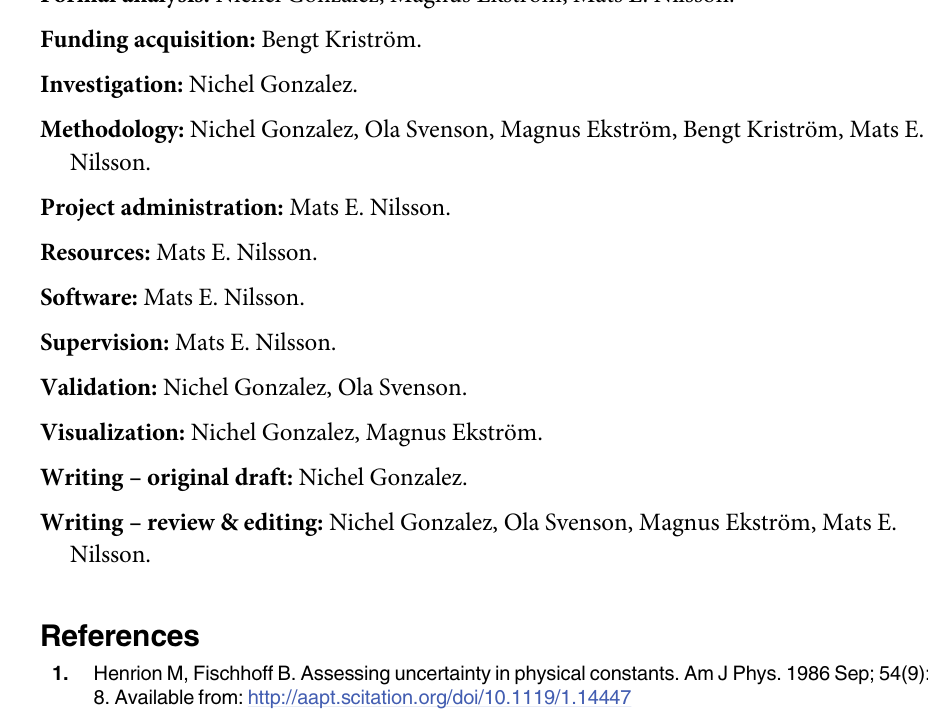
for the left pane. The solid lines are fitted to point judgments and the dotted lines are fitted to the mid4 judgments. The figure shows that the expected density for the different boxes are not the same because the regression lines intersect 1.0 on the y-axis at different points for each of the box sizes, large (blue), medium (red) and small (green). The average expected density for each box size is indicated by the value on the x-axis where the regression line goes through the horizontal line at 1.0 on the y-axis. S1 Table. Model estimates: Mixed effect model illustrated in Fig 3. True weight of boxes and judgment estimates were log transformed for this analysis. Main effects of true box weight, the type of judgment estimate (point vs mid4), and size (small, medium, large). First-order interaction effects between true weights, type of judgment estimate, and size. Random effects for true weight, type of judgement estimate, and